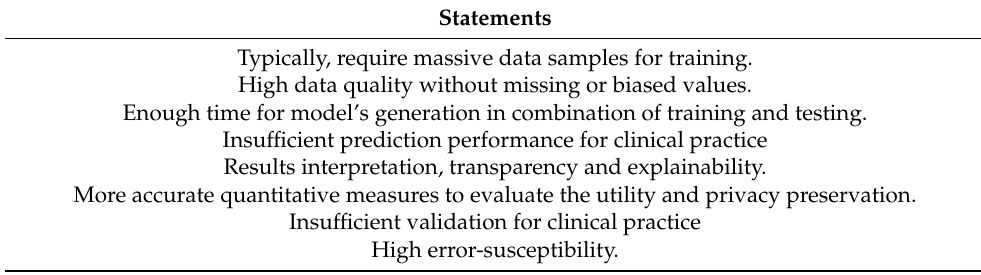
Table 4. Disadvantages in using the Machine Learning/Big Data-AI approaches in research on multimorbidity